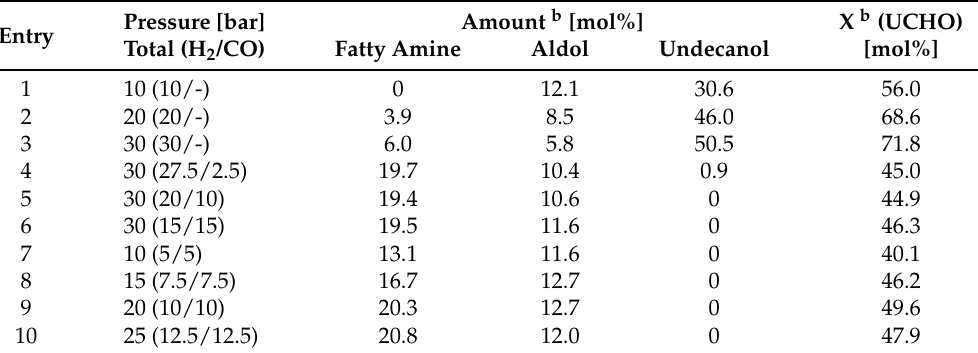
Table 1. Effect of reaction gas composition and pressure on the reductive amination of undecanal with diethylamine a